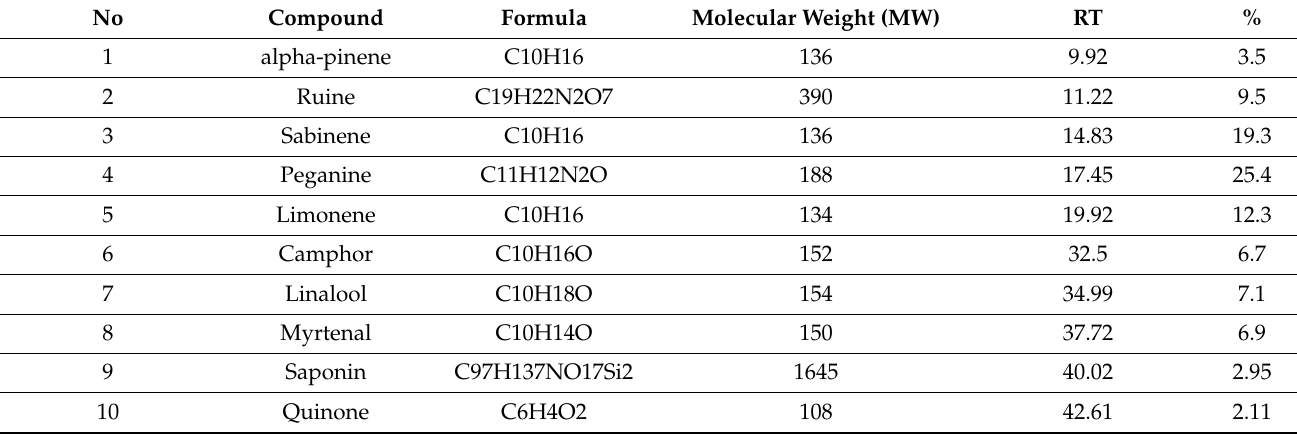
Table 4. Major compounds identified in the H. orientalis L. hydroalcoholic extract using GC–MS method.